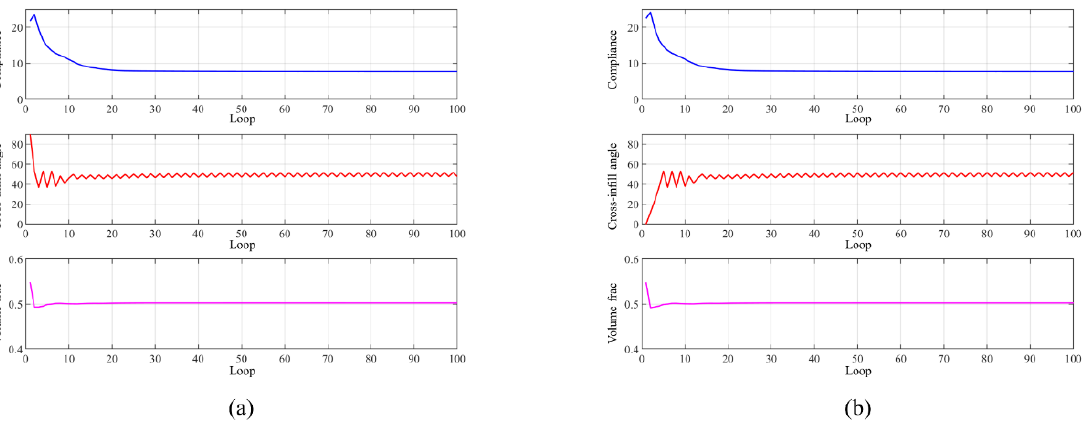
Figure 14. The convergence histories of the optimization processes from cross-infill initial guesses of ( a ) 90°-90° and ( b ) 90°-0°.